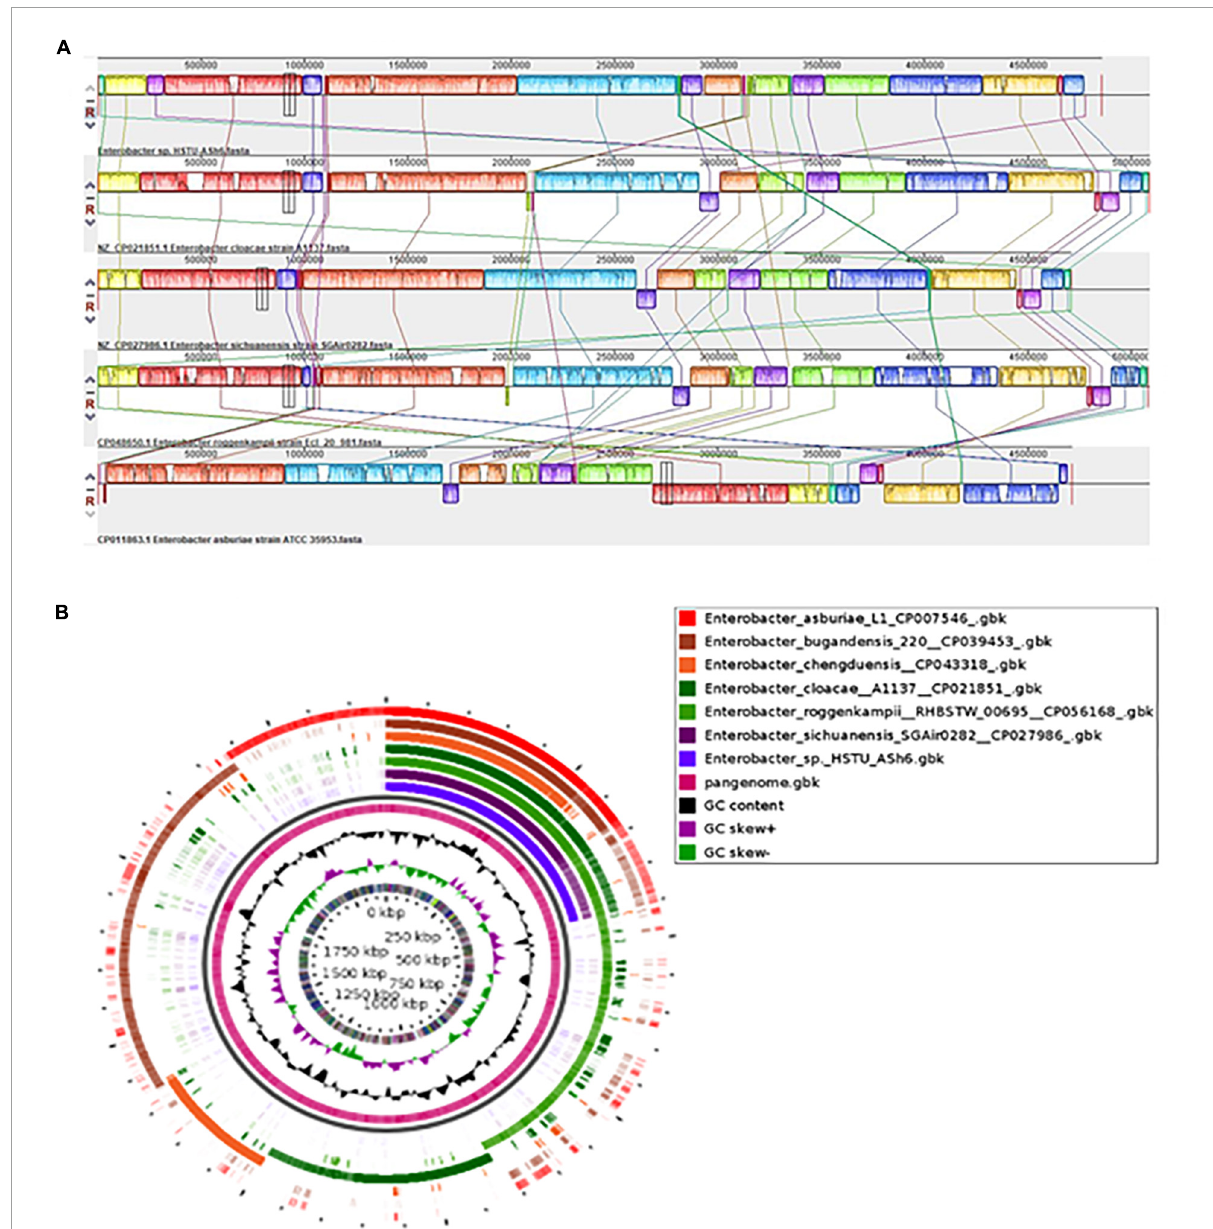
FIGURE4 (A) Synteny analysis of Enterobacter sp. HSTU-ASh6 strain with other close related strains. (B) Pangenomic comparison map of Enterobacter sp. HSTU-ASh6 with nearest homologs. Multiple genome sequence analysis of Enterobacter sp. HSTU-ASh6 with other closely related strains. The same color module represents the homologs region. Good homology of Enterobacter sp. HSTU-ASh6 and other E. cloacae strains is